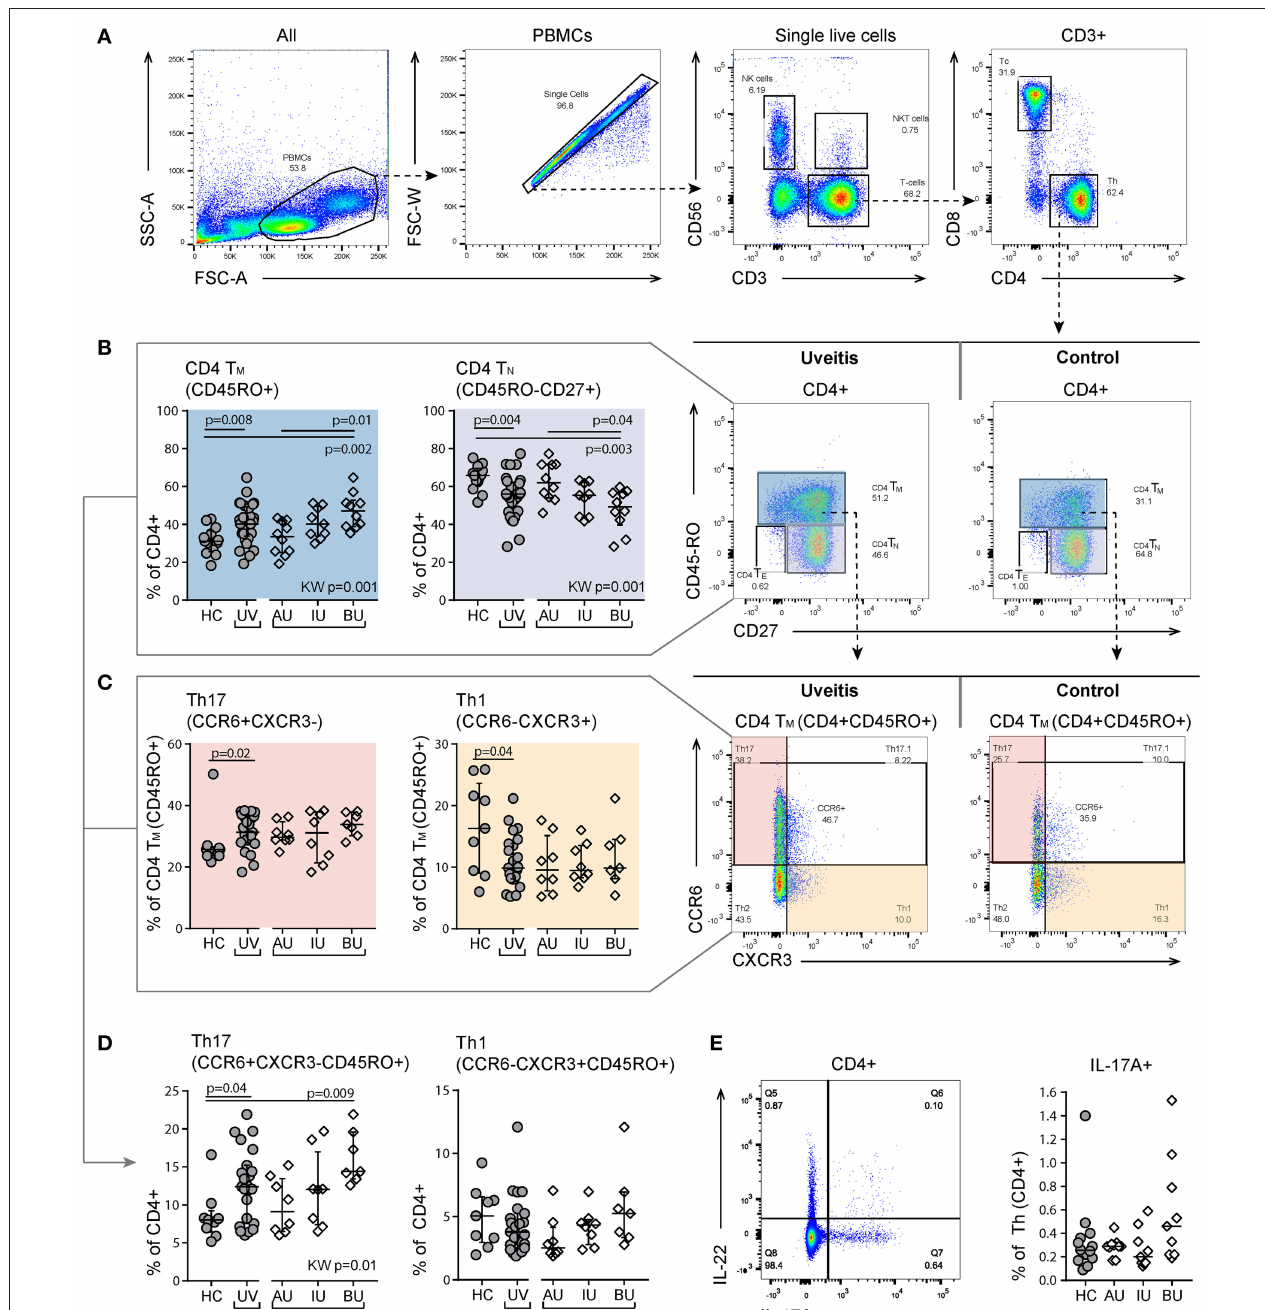
FIGURE 2 | Heterogeneity in memory T cell subsets and abundance of CXCR3-CCR6 + (Th17) cells between uveitis subtypes. (A) Gating strategy of a representative sample used to identify T helper (Th. CD3 + CD4 + ) and cytotoxic T cells (Tc. CD3 + CD8 + ). (B) Shift in proportion from naïve to memory T helper cells in uveitis patients compared to controls. The proportion of CD4 + T N and CD4 + T M cells shows heterogeneity between the uveitis subtypes and the observed difference between uveitis and healthy controls is mainly driven by BU patients. (C) Within the CD4 + T M there is an increase of Th17 (CCR6 + CXCR3-) and a decrease in Th1 (CCR6-CXCR3 + ) cells in uveitis patients compared to healthy controls. (D) BU displayed an increase in Th17 cells within the total CD4 + T cell population compared to the other patient groups. (E) left: gating strategy used to identify IL-17A expressing CD4 + T helper cells using the intracellular cytokine panel. Right: percentage of IL-17A + cells within the total CD4 + T cell population. The gating of intracellular cytokines (including IL17A) from CD4T cells in given in more detail in Figure S2 . Bars indicate the median and interquartile range. P -values between HC and UV are from Wilcoxon rank-sum test, p -values between uveitis subgroups are from Kruskal–Wallis (KW) test with post-hoc Dunn’s correction for multiple testing. AU, HLA-B27 associated anterior uveitis; BU, Birdshot uveitis; HC, healthy control; IL, interleukin; IU, idiopathic intermediate uveitis; T E , effector T cell (CD45RO-CD27-); Th, T helper cell (CD3 + CD4 + ); T M , memory T cell (CD45RO + ); T N , naïve T cell (CD45RO-CD27 + ); PBMC, peripheral blood mononuclear cell; TNF, tumor necrosis factor; UV, all uveitis patients combined.